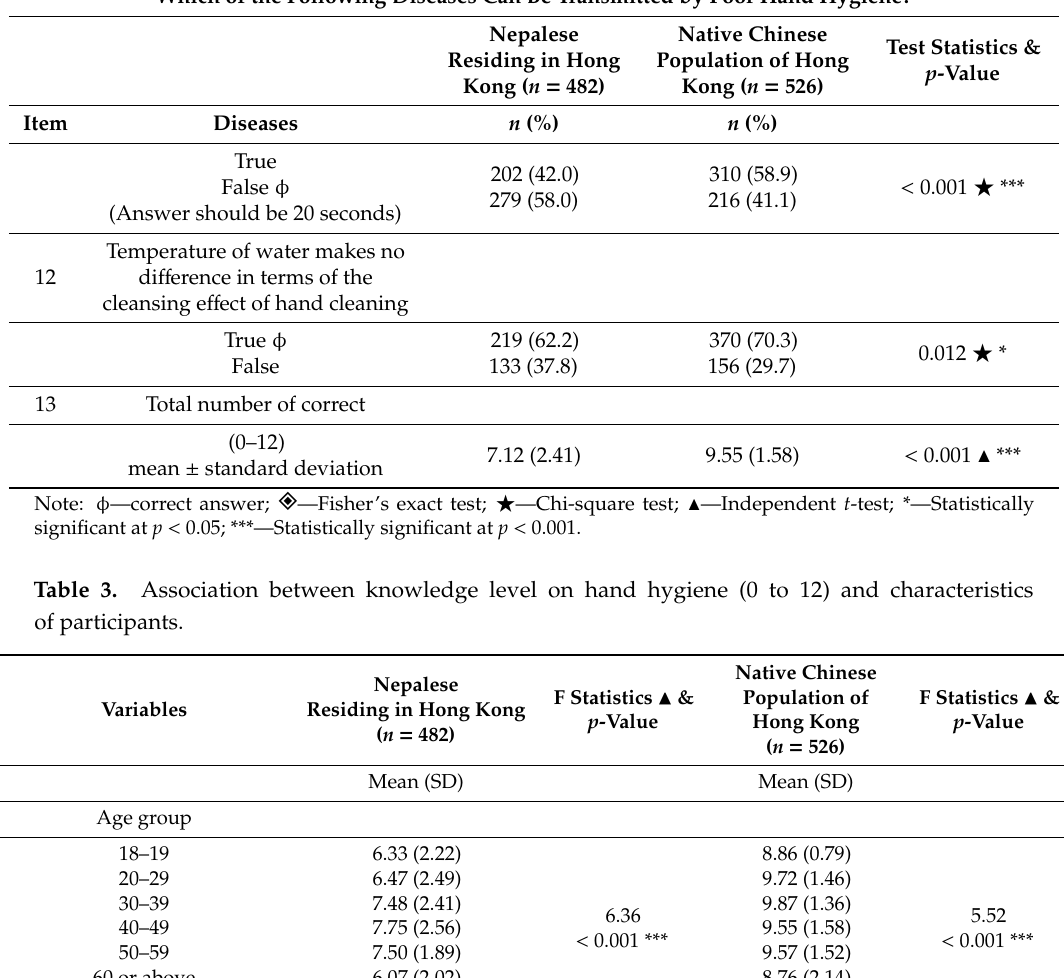
Table 2. Knowledge level on hand hygiene (0 to 12).